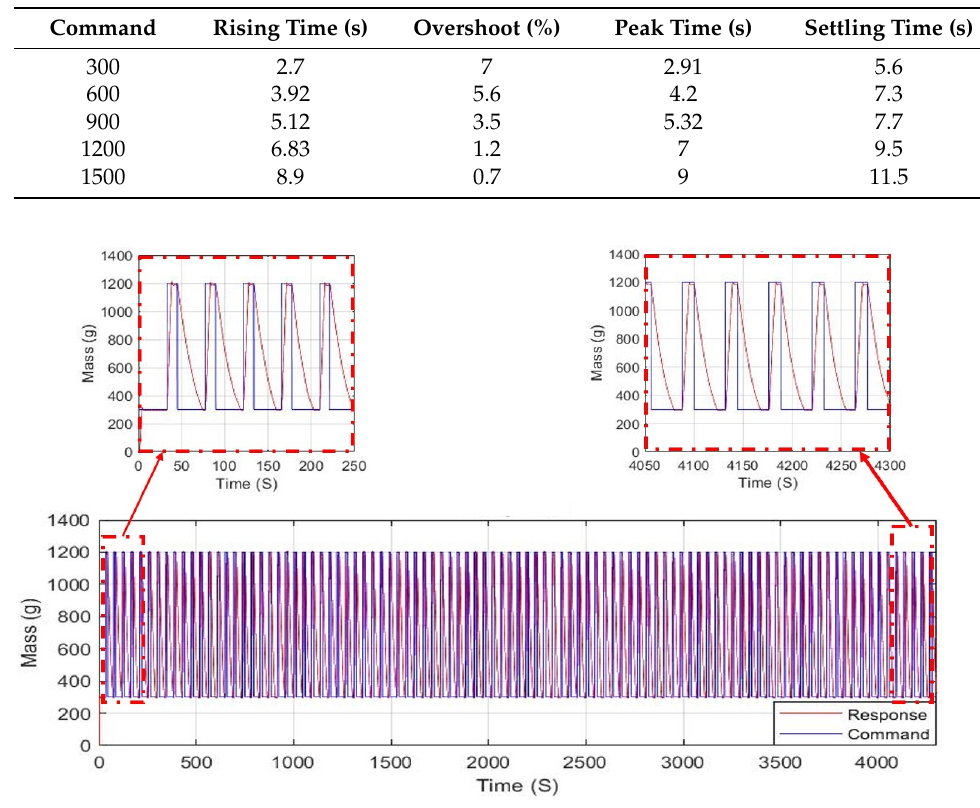
Table 1. Step response characteristics for the NiTiNOL spring’s force.